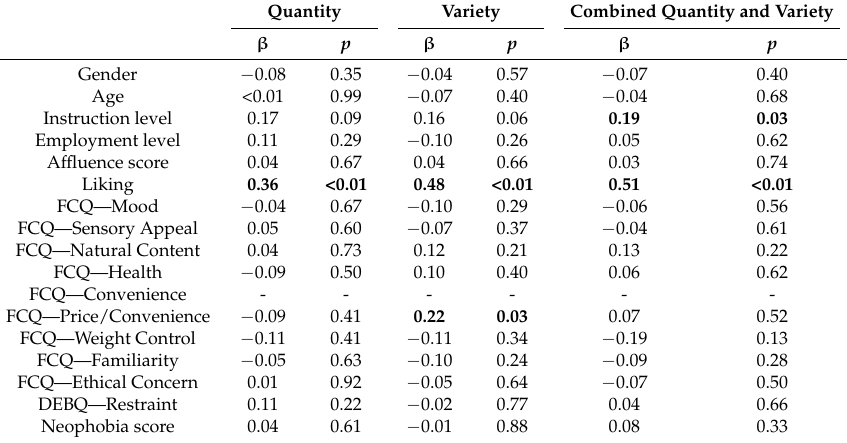
Table 5. Results of the regression analyses using demographic characteristics and all liking and attitude variables to predict quantity, variety and combined quantity and variety scores in Italian participants ( n = 152). Regression equations: Quantity: R = 0.46, R 2 = 0.21, adjusted R 2 = 0.12, F (16,151) = 2.28, p = 0.01; Variety: R = 0.64, R 2 = 0.41, adjusted R 2 = 0.34, F (16,151) = 5.78, p < 0.01; Combined quantity and variety: R = 0.59, R 2 = 0.34, adjusted R 2 = 0.27, F (16,151) = 4.41, p <